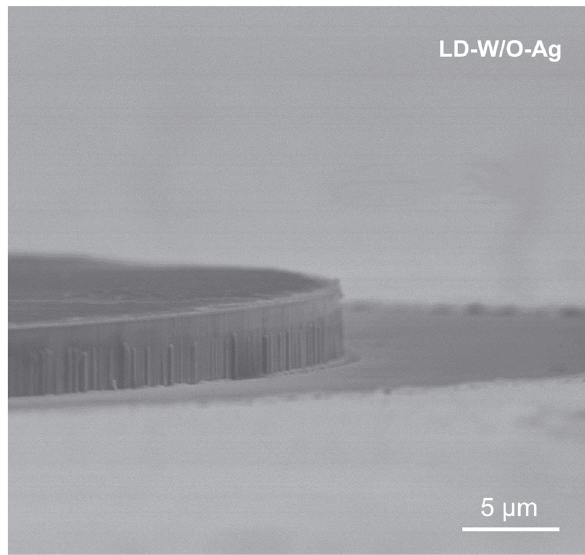
Figure 6: Side-view SEM image of the LD-W/O-Ag.